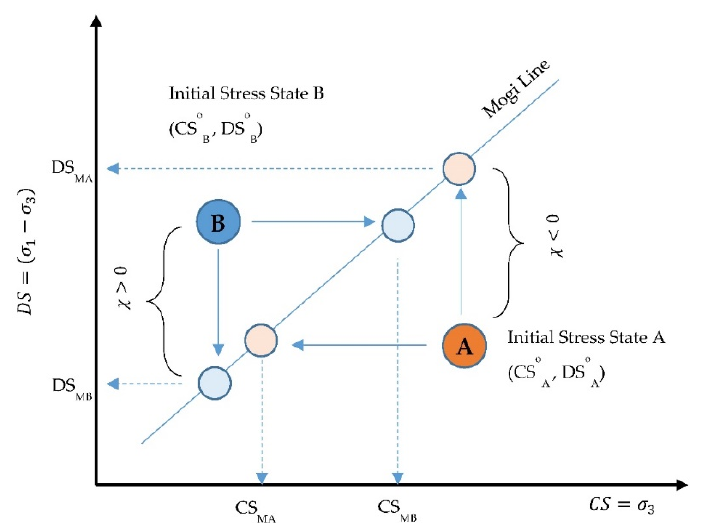
Figure 3. Concept and method used to derive the Brittle–Ductile State Parameter ( χ ) and the Brittle– Ductile Stress Index (I BD ). DS = Deviator stress; CS = Confining Stress; A and B are formations at initial confining and deviator stress states (CS 0 , DS 0